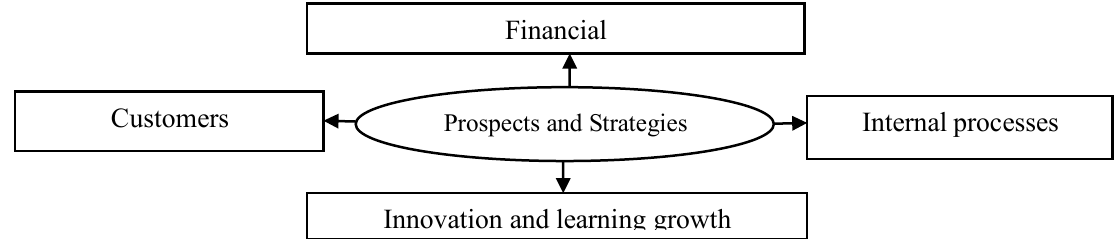
Figure 1 . Balanced Scorecard Framework